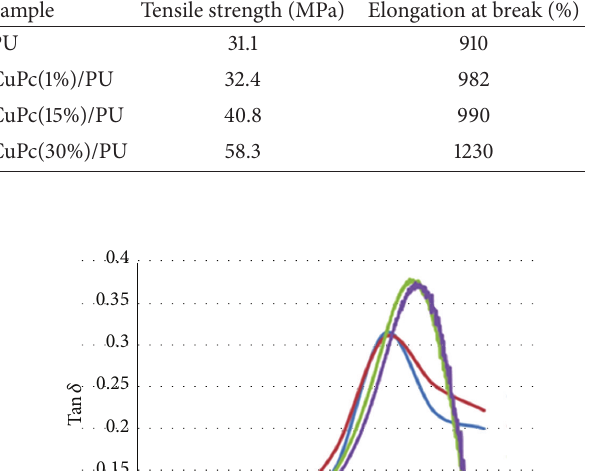
Stress-Strain Analysis . The stress-strain tests for CuPc/PU of CuPc reinforcement on the physical and mechanical from PU to CuPc.